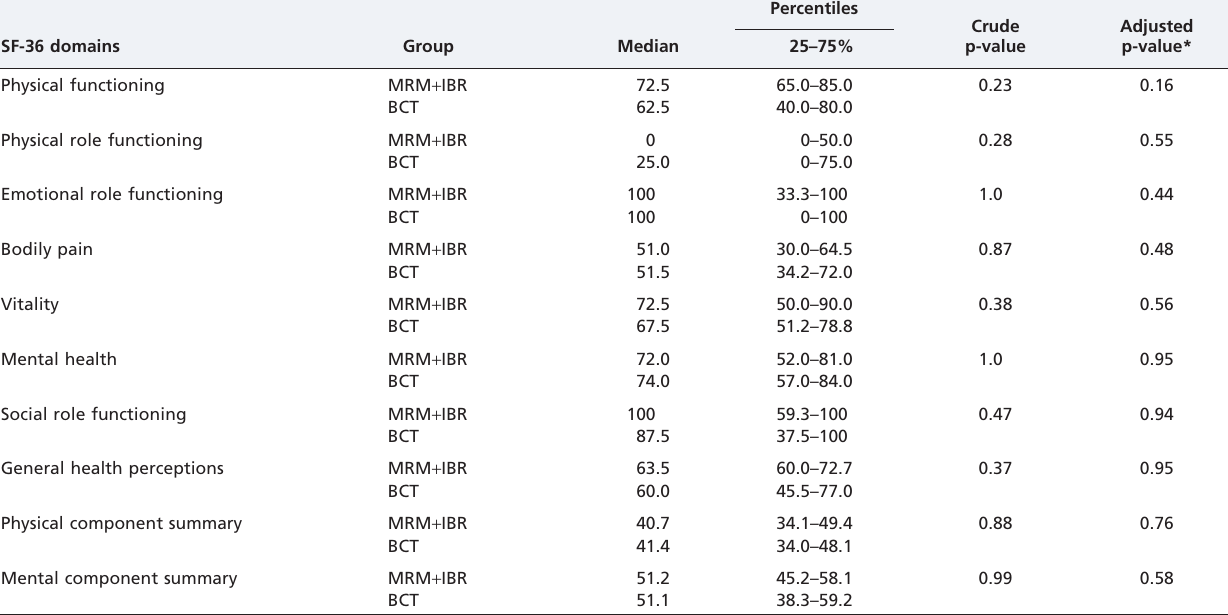
Table 6 - Comparison between the median SF-36 scores for women with breast cancer submitted to MRM + IBR (n = 26) or BCT (n = 44).